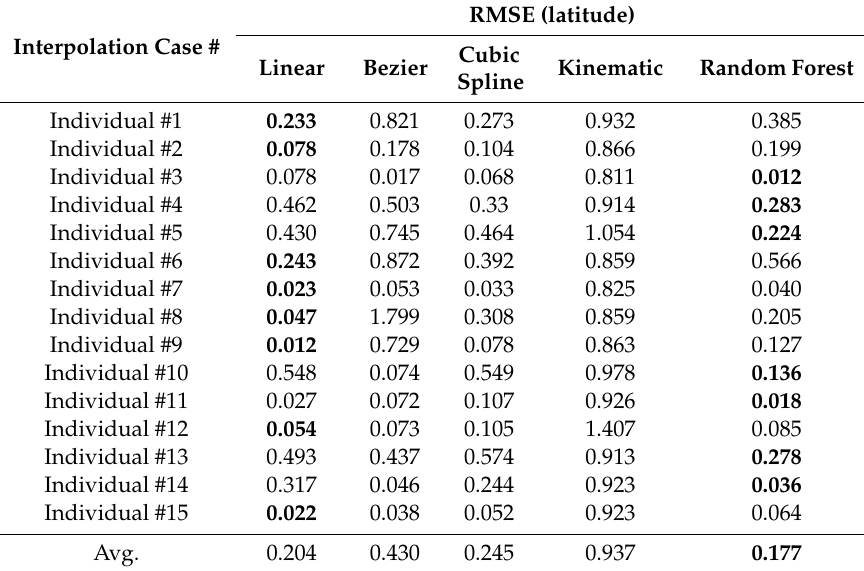
Table 6. Comparison of RMSEs for missing latitude records